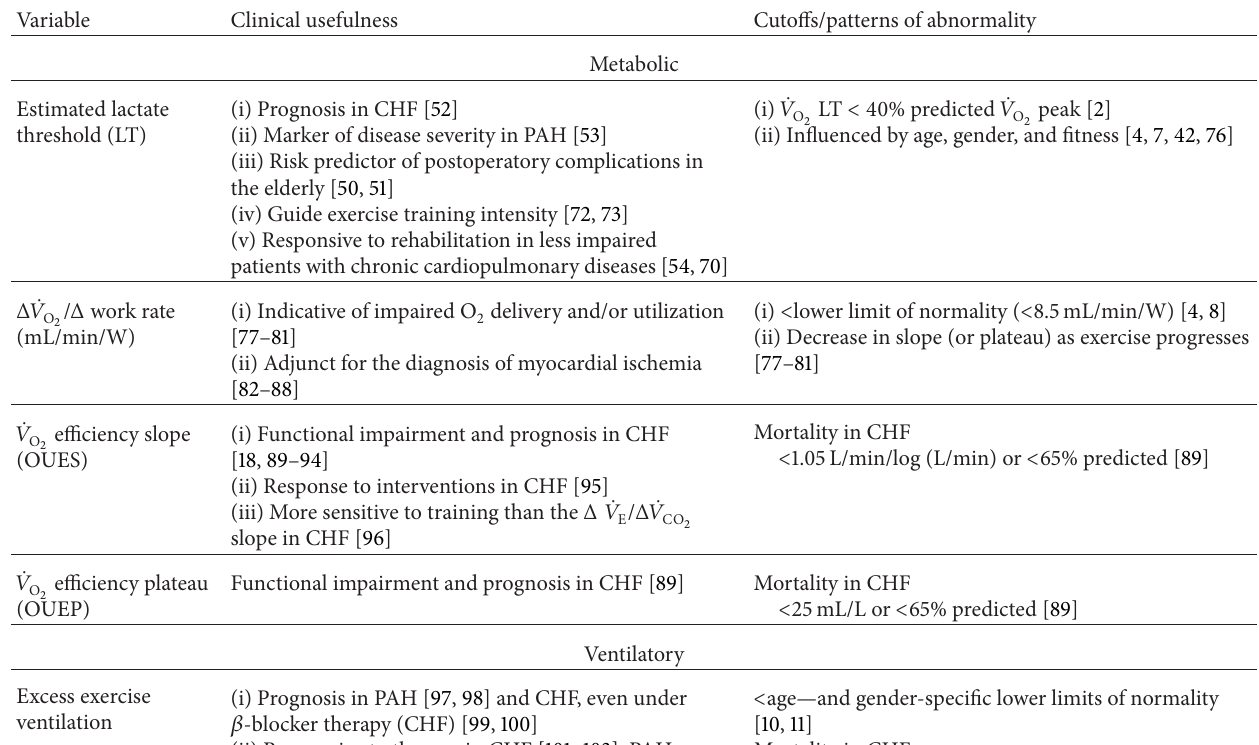
Table 1: Clinical usefulness and suggested cutoffs of selected dynamic responses to rapidly incremental